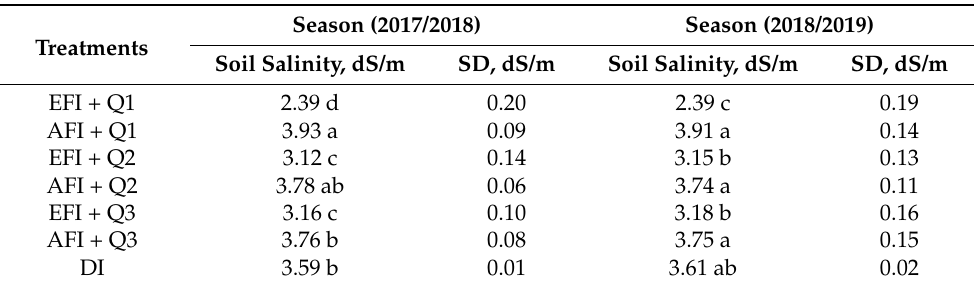
Table 5. Effect of irrigation method (EF, AF, and DI) and flow rate (0.47 (Q1), 0.95 (Q2), and 1.43 L/s (Q3)) on soil salinity in the first and second growing seasons.